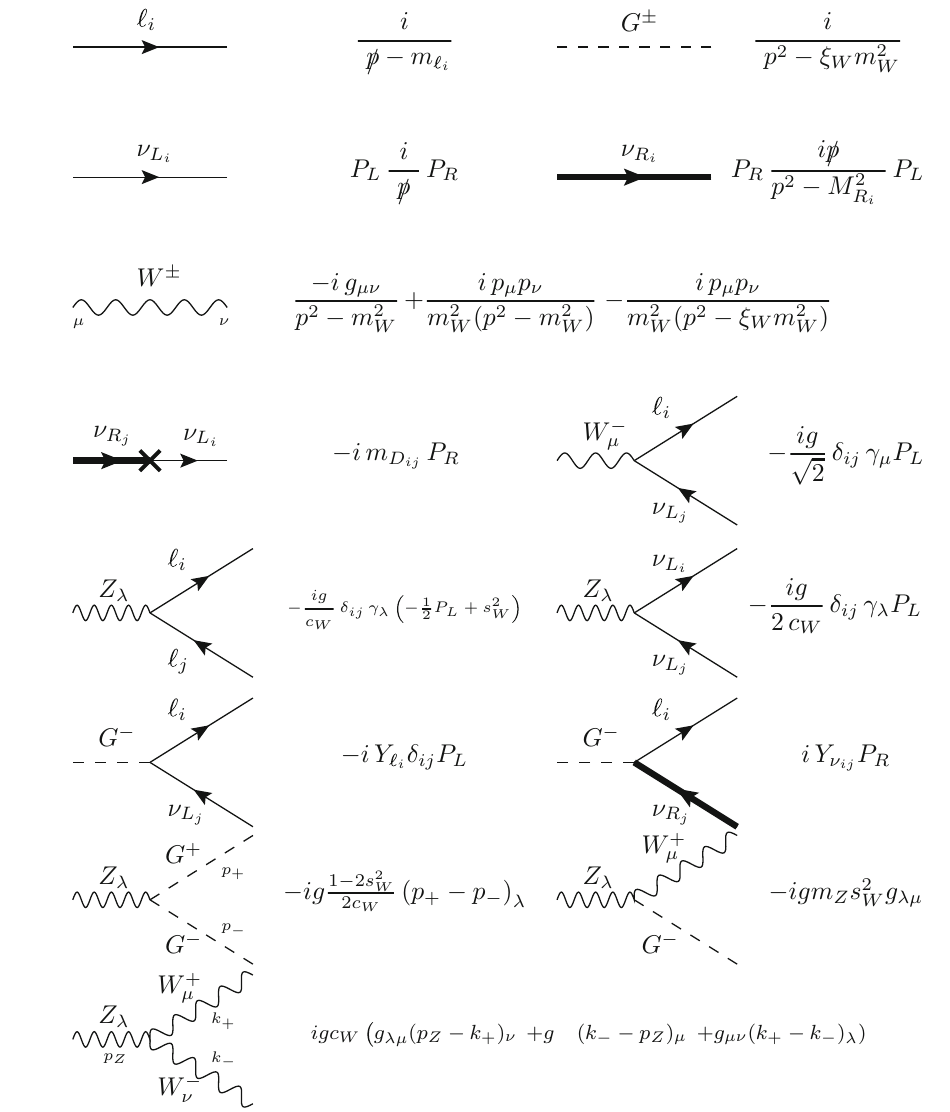
Fig. 1 Relevant Feynman rules and sign conventions for the MIA computation in a generic covariant gauge. The momentum convention is that all boson momenta are incoming. The solid thick line denotes the right handed neutrino fat propagator, as defined and computed in [27]. The cross denotes our unique LFV = v Y ν insertion given by m D ij ij